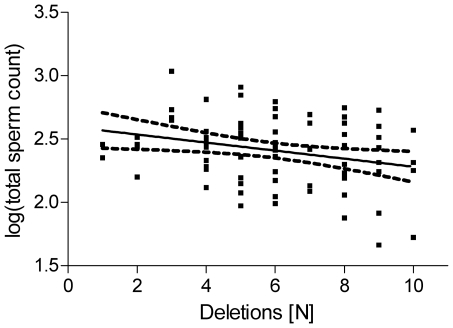
Significant negative correlation (r = −0.270, P<0.05) of total sperm count with number of deletions in 78 normozoospermic men analysed by 244A array.
P-value calculated on log-transformed total sperm counts.